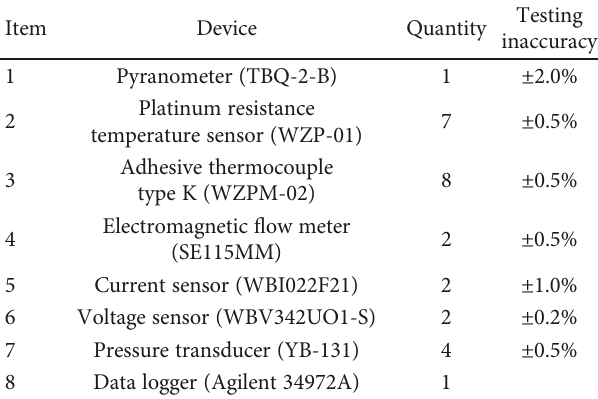
Figure 3: Diagram of heat pipe solar PV/T cogeneration system. Table 1: List of testing